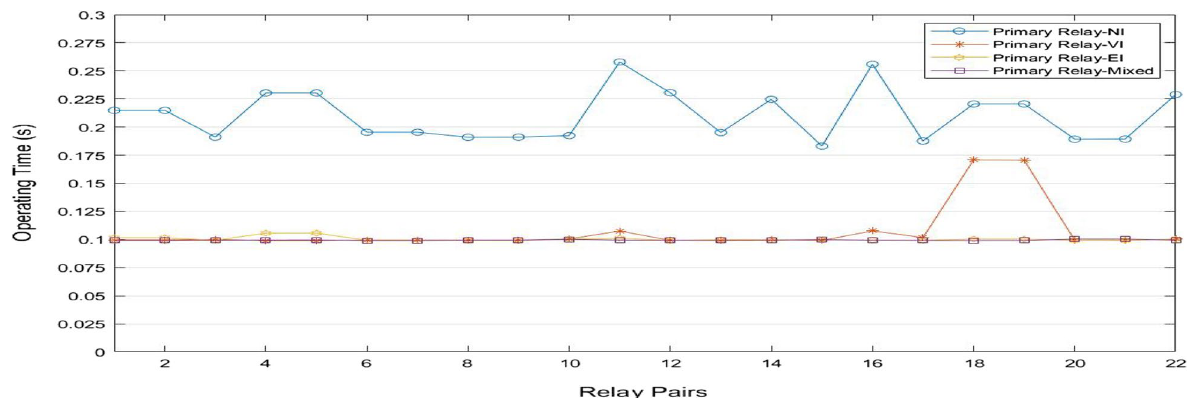
Fig. 5 Primary relay operating time having NI, VI, EI and mixed characteristics in grid-connected mode